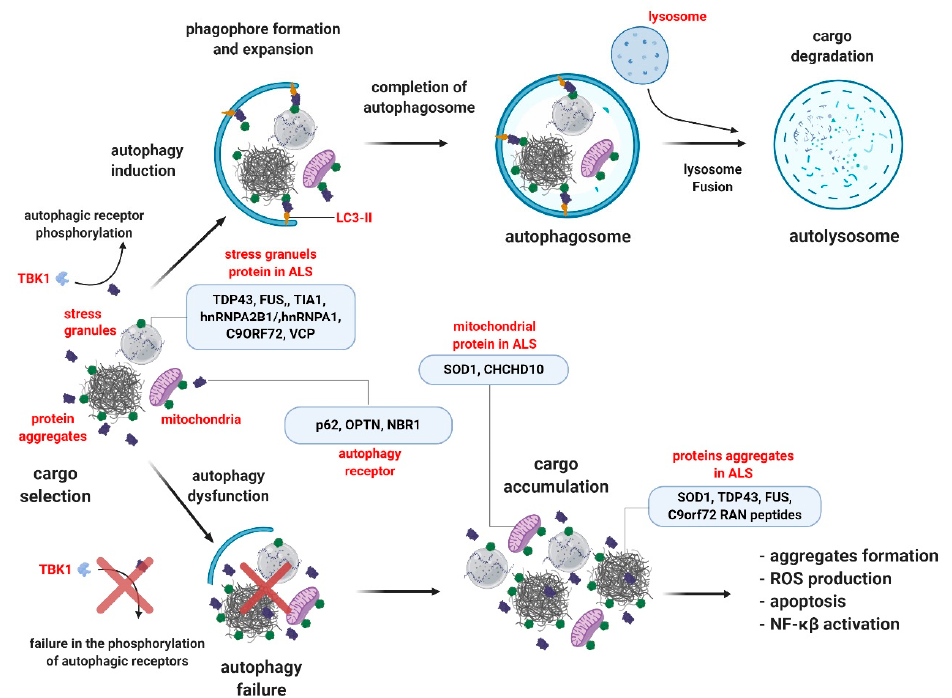
Figure 1. Selective autophagy under physiological and ALS pathological conditions. Protein aggregates, stress granules, and dysfunctional mitochondria are substrates for selective autophagy degradation. Under physiological conditions (upper panel), substrates are bound by selective autophagy receptors, such as p62, OPTN and NBR1 (represented in dark blue) via ubiquitin-binding domains (ubiquitin, in green). Selective autophagy receptors associate with LC3 proteins in the autophagosome (represented in yellow), or other members from the autophagy machinery. Posttranslational modifications in the receptors can enhance the binding with ubiquitinated substrates or the LC3 protein. TBK1 is one of the main kinases acting in this process. The cargo-receptor-LC3 complexes are then sequestered by de novo double-membrane vesicles called the autophagosome, which fuses with the lysosome for the final degradation. Under ALS conditions (lower panel), the failure in selective autophagy can occur through mutations in the genes encoding the receptors themselves or in the TBK1 gene, reducing the activity of the pathway, promoting the accumulation of toxic substrates for motor neurons (Image created with BioRender.com). In ALS, important cargos to be targeted to selective autophagy include protein aggregates, dysfunctional mitochondria, and SGs. Here, we provide an overview of different selective autophagy